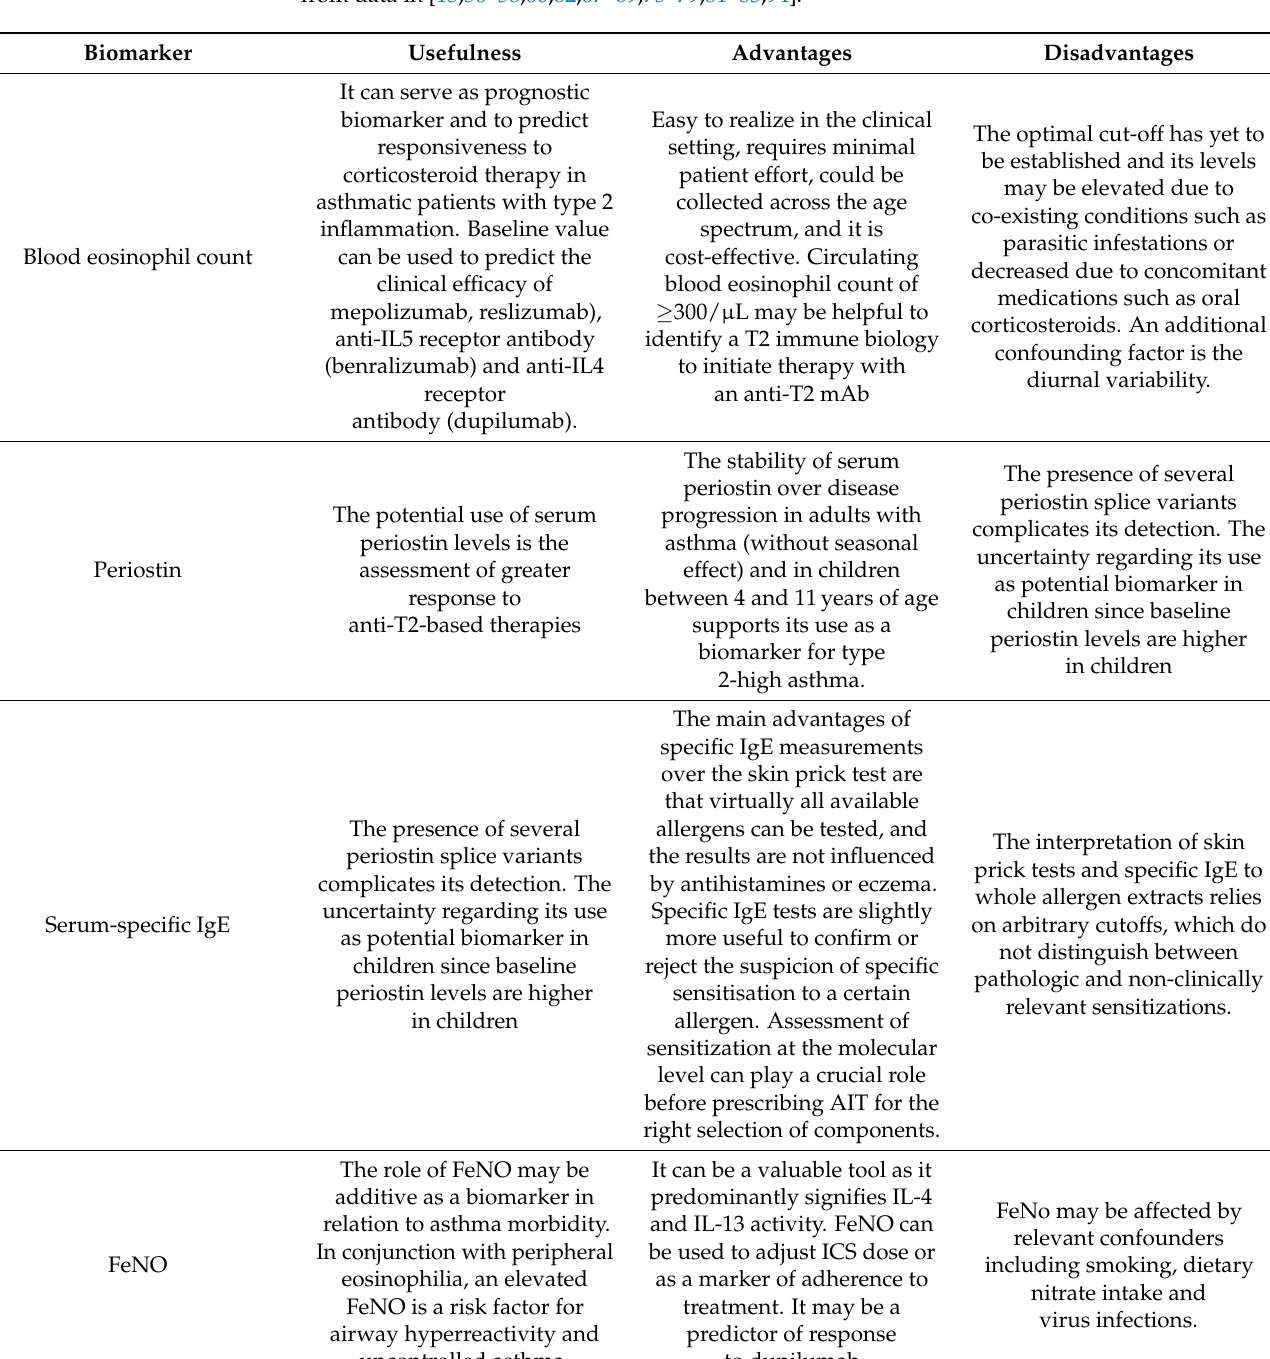
Table 2. Comparison between the advantages and disadvantages of the most employed type 2 asthma biomarkers and those of ECP and EDN. AIT, allergen immunotherapy; ECP, eosinophil cationic protein; EDN, eosinophil-derived neurotoxin; FeNO, fractional exhaled nitric oxide; ICS, inhaled corticosteroid; IgE, immunoglobin E; IL, interleukin; mAb, monoclonal antibody.